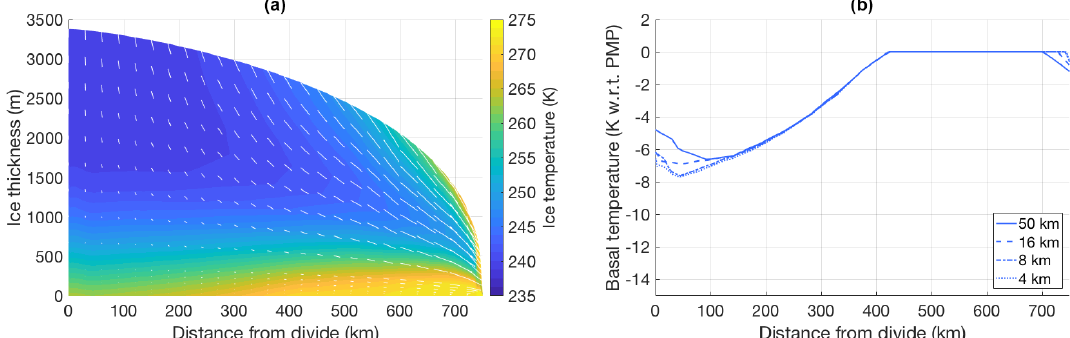
Figure 7. (a) Ice temperature and velocity vectors for the steady-state ice sheet in experiment IV, as produced by UFEMISM with a 4km ice-margin resolution. (b) Basal temperature transects for the different simulations in the same